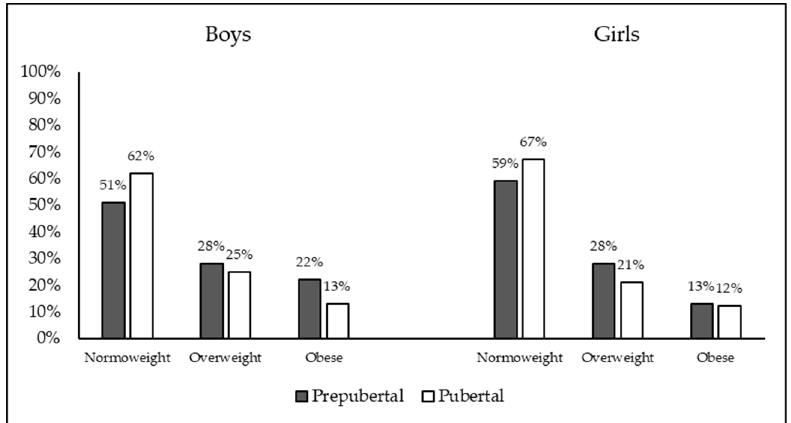
Figure 1. Percentage of the sample with different weight classifications as a function of sex and pubertal status.